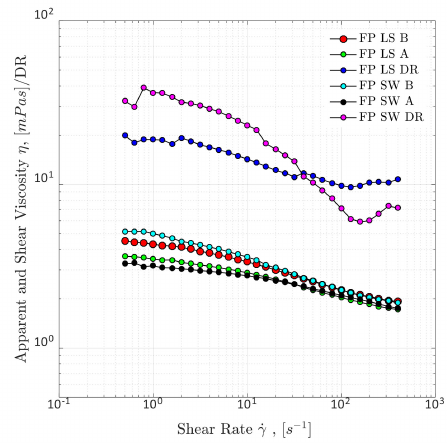
Figure 9. Viscosity loss and mechanical degradation of polymer solutions through stainless-steel pipe before entering the core plug. B represents the fresh solution while A represents the degraded solution through stainless-steel pipe